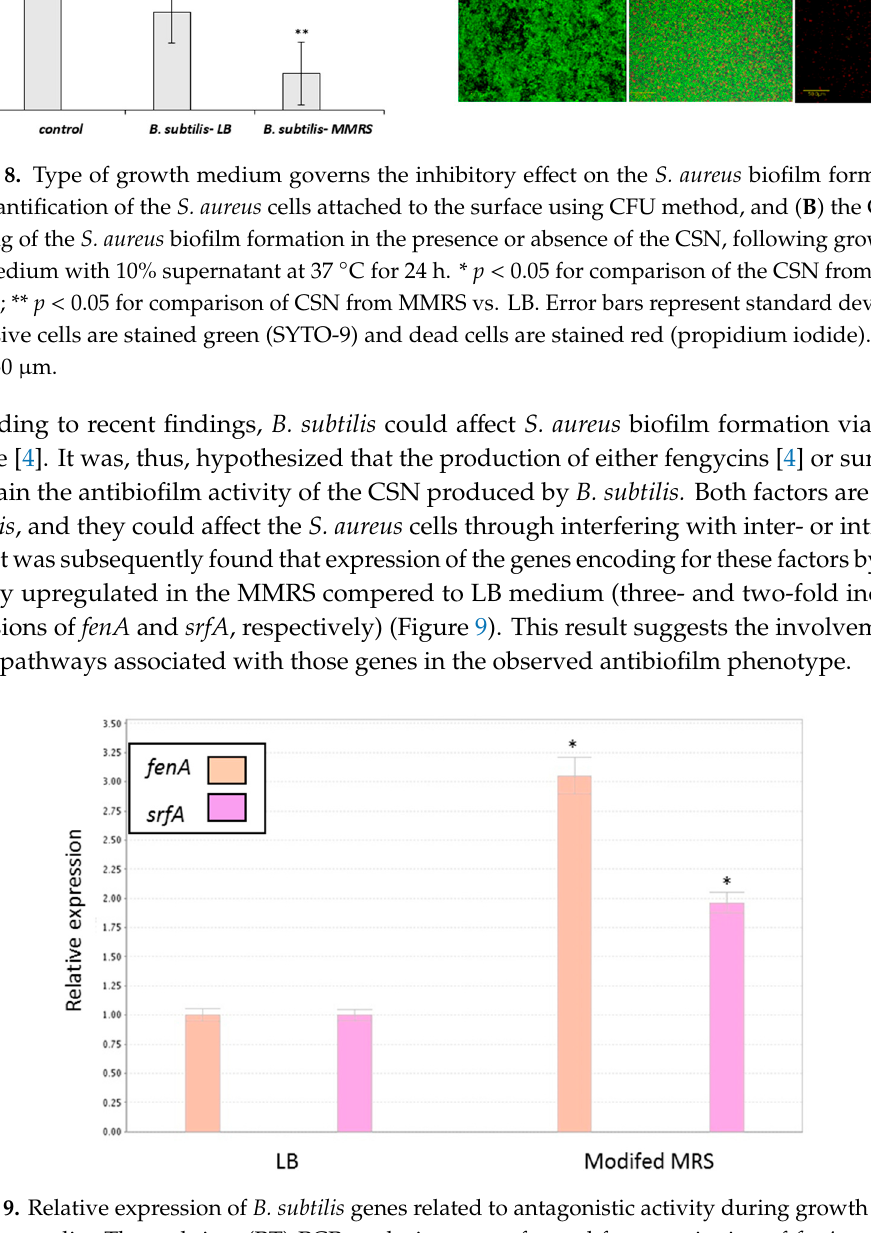
11 of 16 Figure 7. Conditioning supernatant (CNS) of the B. subtilis culture inhibits biofilm formation by Staphylococcus aureus . S. aureus biofilm formation was determined after growth in TSB medium with 10% CNS at 37 °C for 24 h. ( A ) S. aureus biofilm formation quantification by crystal violet method. ( B ) Quantification of live bacteria attached to surface using CFU method. * p < 0.05 for comparison of the control and tested samples . Error bars represent standard deviation (SD). ( C ) Confocal laser